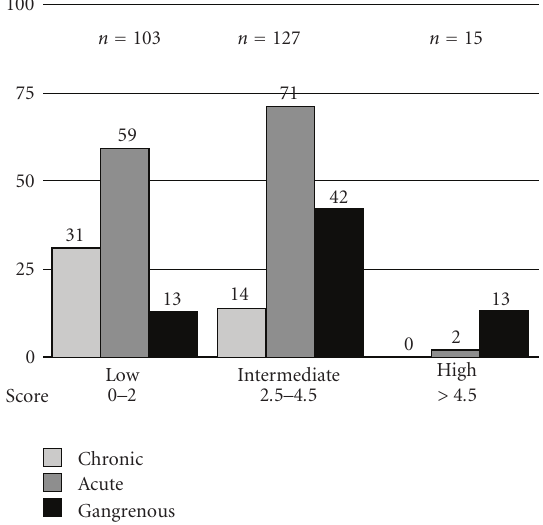
Figure 2: Distribution of cholecystitis according to probability group in the validation